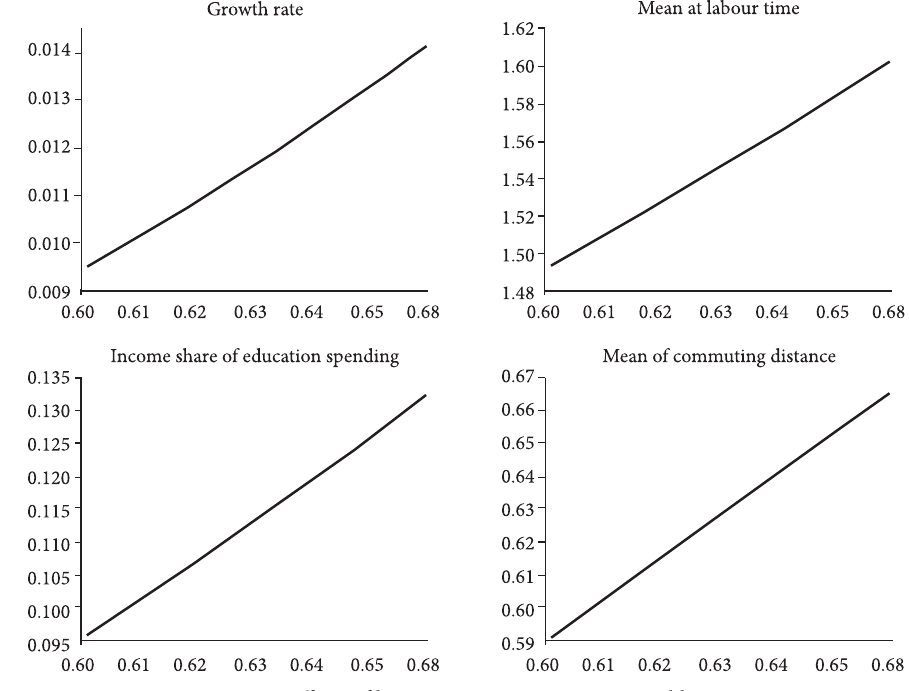
Fig. 1. Effects of heterogeneity on economic